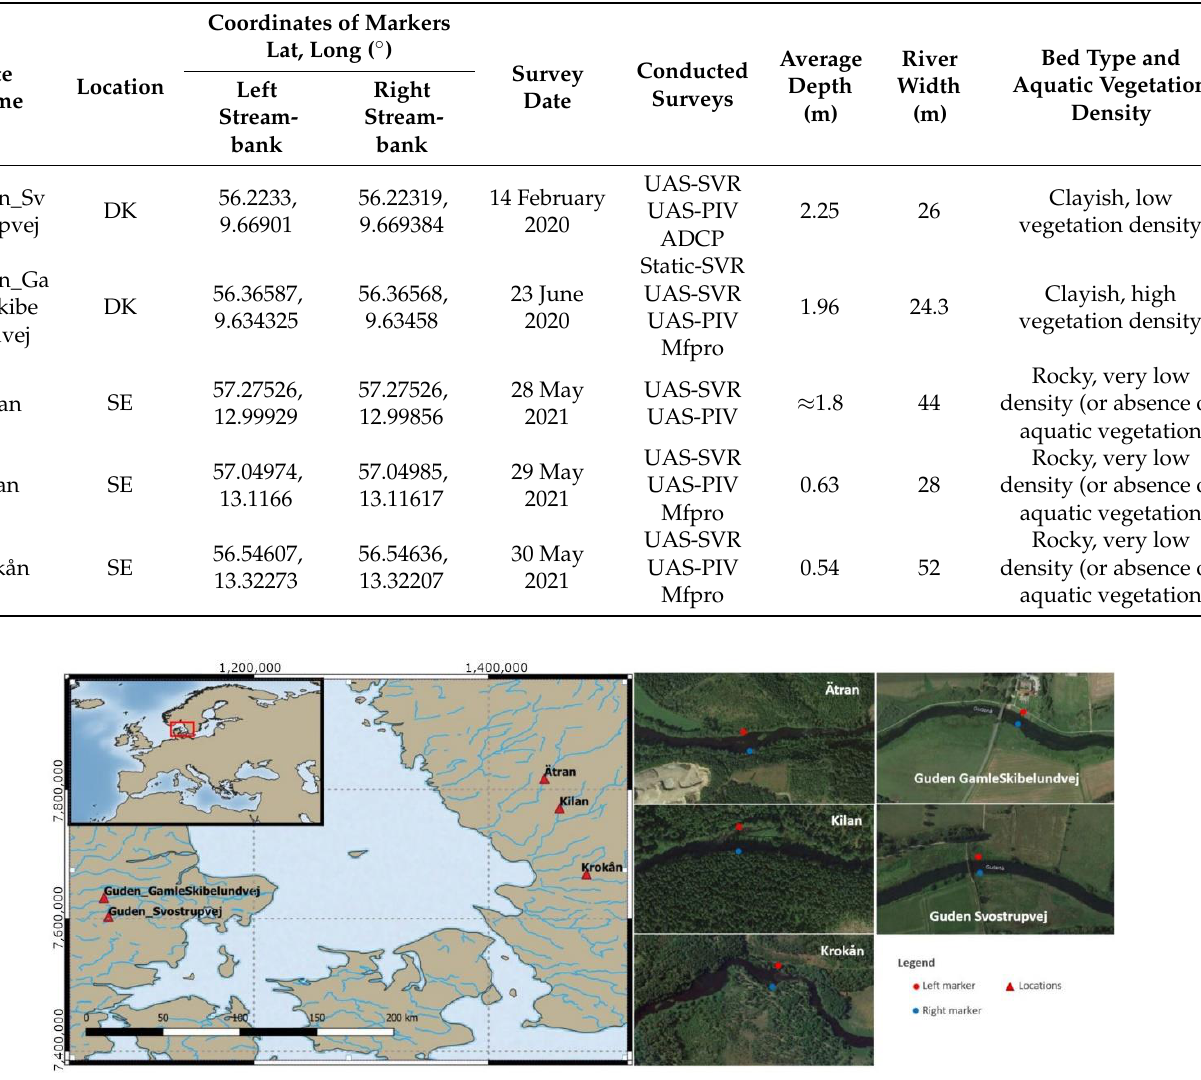
Figure 2. Map with the location of the different sites in Sweden and Denmark with detailed satellite images of the sites. Coordinate reference system is WGS84/Pseudo-Mercator. Source for the left- panel map is https://www.naturalearthdata.com/ (last access 3 January 2022), river outlines are from https://www.diva-gis.org/gdata (last access 3 January 2022), and the sites images are